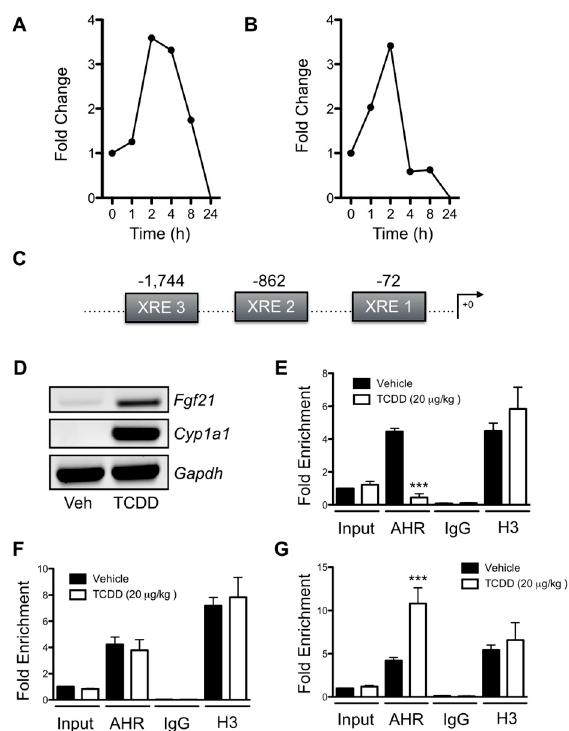
Figure 6. Transient AHR agonist induction of Fgf21 transcription correlates with distinct binding events at the Fgf21 promoter. ( A ) 6 nM 2,3,7,8-tetrachlorodibenzo- p -dioxin (TCDD) and ( B ) 30 µ M cinnabarinic acid transiently induce Fgf21 transcription in Ahr fl/fl primary hepatocytes at 2 h, with gene expression subsiding by 24 h. ( C ) Schematic indicating the locations of XRE1, XRE2, and XRE3, within the Fgf21 promoter. ( D ) Exposure of female Ahr fl/fl mice ( n = 3) to 20 µ g/kg TCDD induces hepatic Cyp1a1 and Fgf21 transcription at 2 h, and is associated with ( E ) reduced AHR binding at XRE3. ( F ) AHR exhibits constitutive, agonist-independent binding at XRE2. ( G ) TCDD exposure in Ahr fl/fl females increases AHR binding to XRE1 at 2 h. Gene expression is calculated as fold-change from time point zero. Chromatin immunoprecipitation (ChIP) data are calculated as fold enrichment from vehicle input and presented as mean ± SEM. All experiments were performed in triplicate. Statistical analysis was performed using a Student’s t test, with significant differences relative to vehicle denoted as *** p < 0.001.